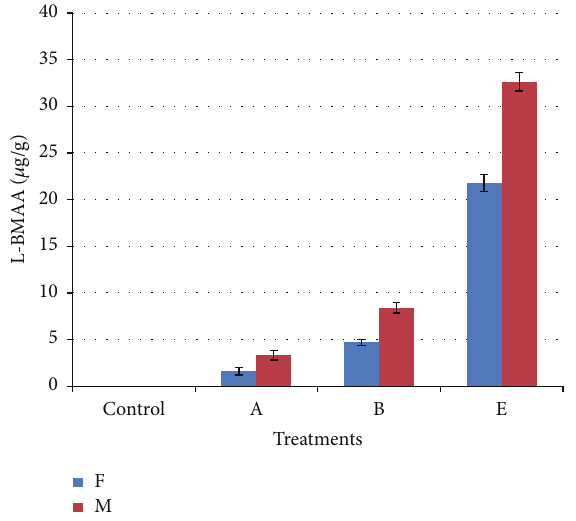
Figure 6: Comparison of L-BMAA concentrations ( 𝜇 g/g) in brains ofmaleandfemalemiceasdetectedbyLC/MS/MSchromatography. T-bars represent the mean of 𝑛 (𝑛 = 3 ) ± SD. A, B, and E: mice treated (0.03, 0.3, and 3 mg/g BW) groups.